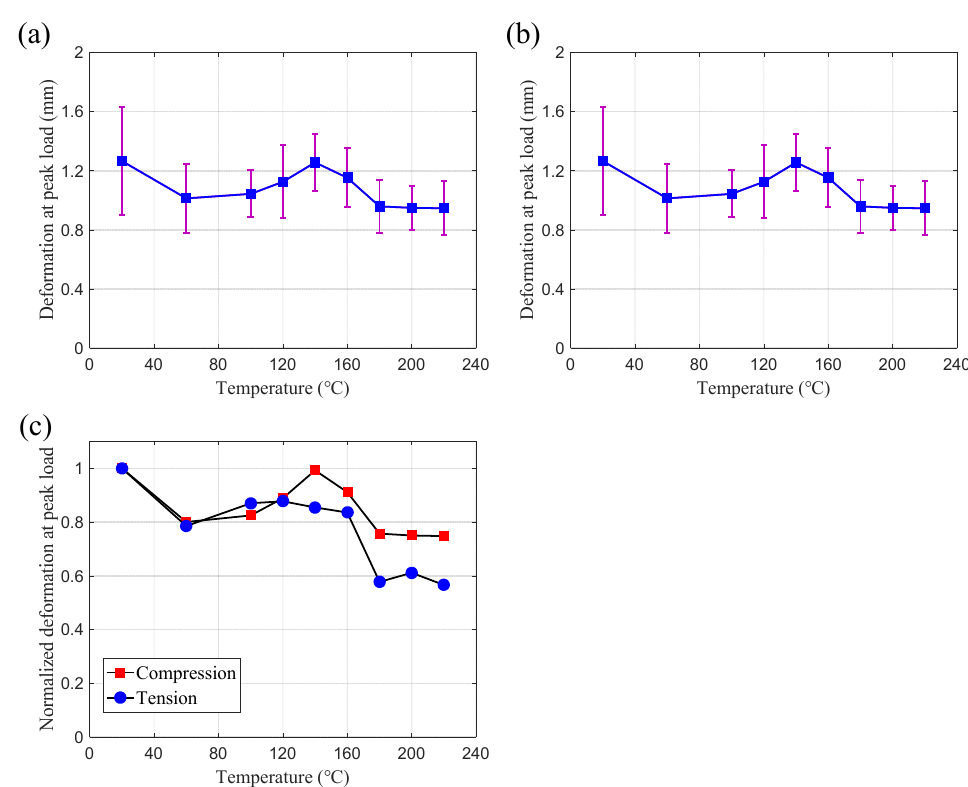
Figure 12. Deformation at the peak load: (a) compression; (b) tension; and (c) normalized value.